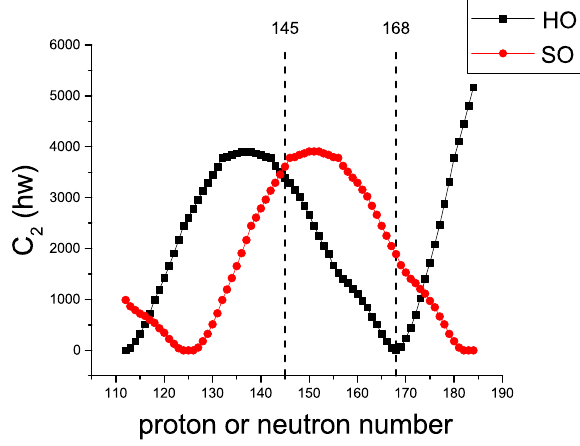
Figure 6. The same as Fig. 1. An island of shape coexistence is predicted within proton or neutron numbers 145 −